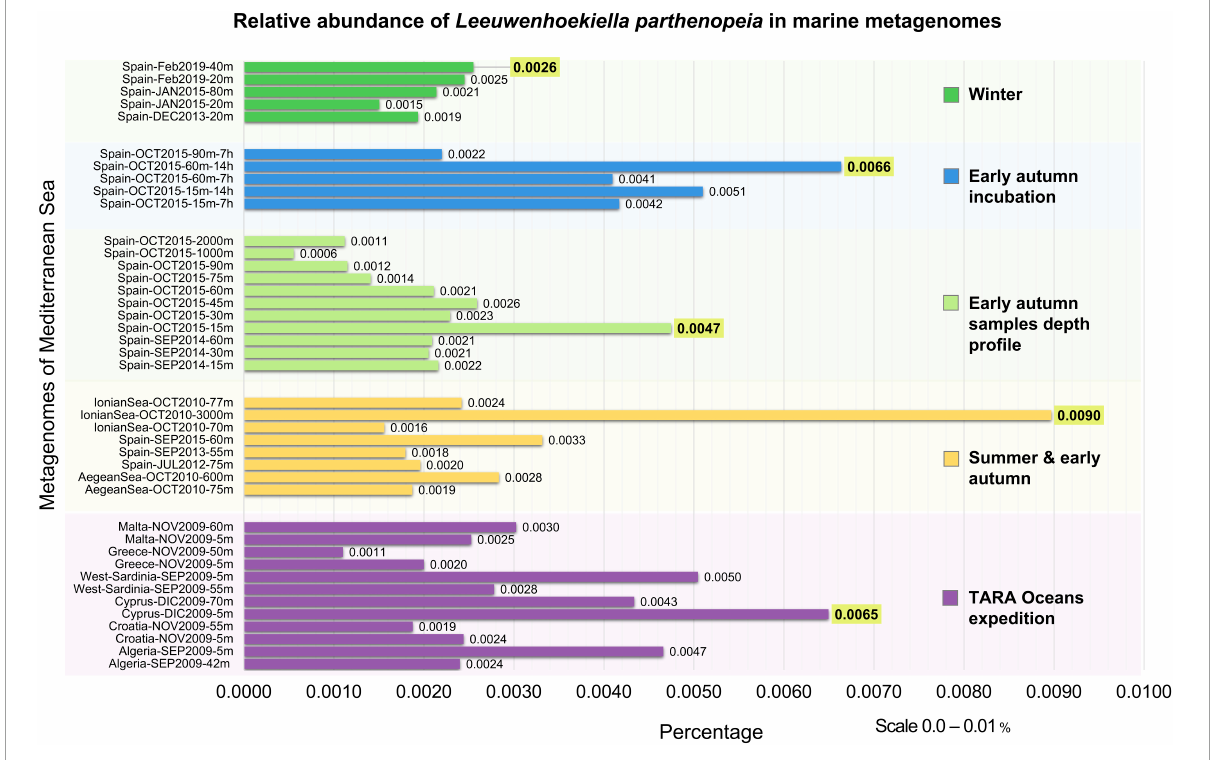
FIGURE2 Occurrence of Leeuwenhoekiella parthenopeia Mr9 T in marine metagenomes from the Mediterranean Sea in the five different categories of metagenomic collections. Y-axis: winter, early autumn incubation, early autumn depth profile stratification, summer and early autumn, and Tara Oceans expedition. X-axis: relative abundance in percentage with the scale from 0.0 to 0.01%. The higher relative abundance for each data block is highlighted in